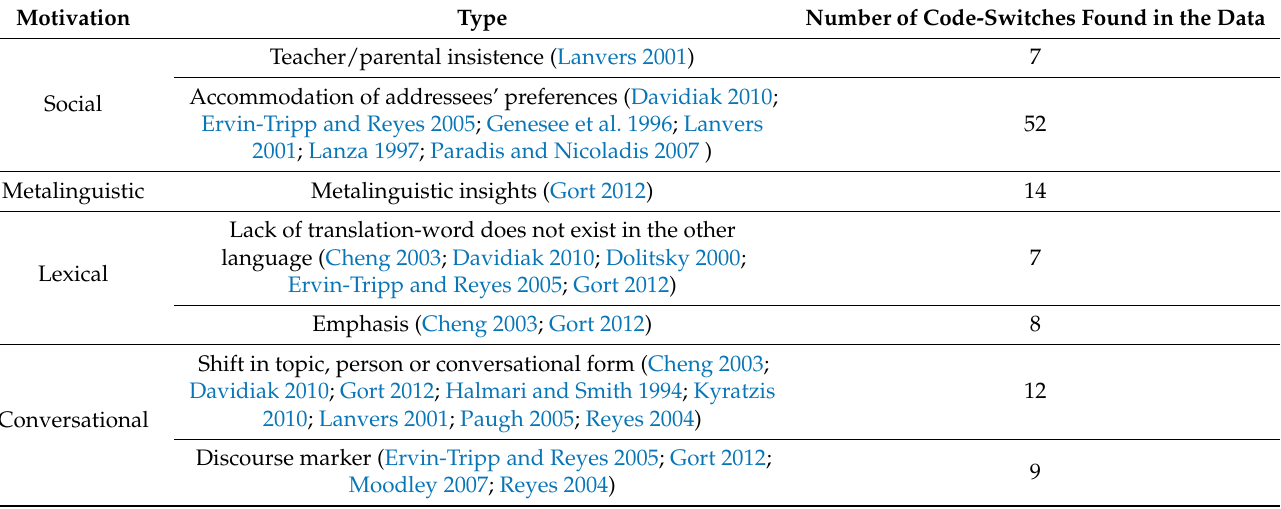
Table 4. Overview of the factors underlying code-switching in bilingual